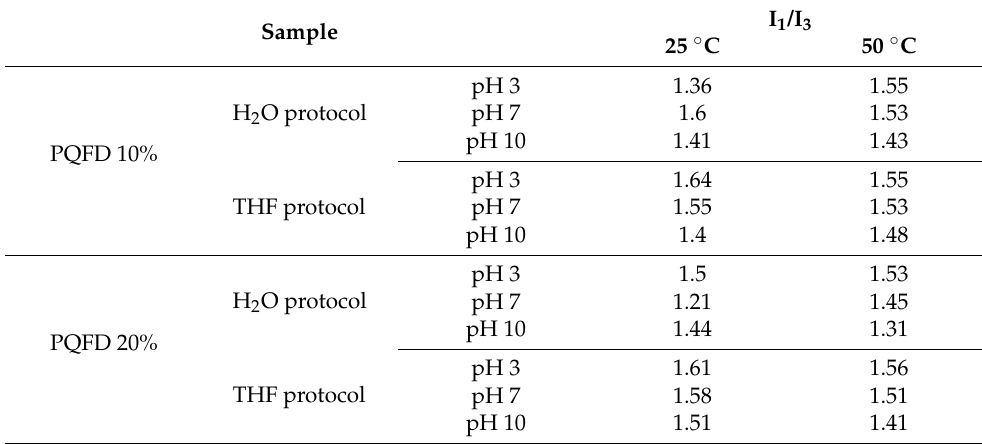
Table 3. I 3 values for the PQFD amphiphilic copolymers at different pH and temperature conditions (c = 1 × 10 − 3